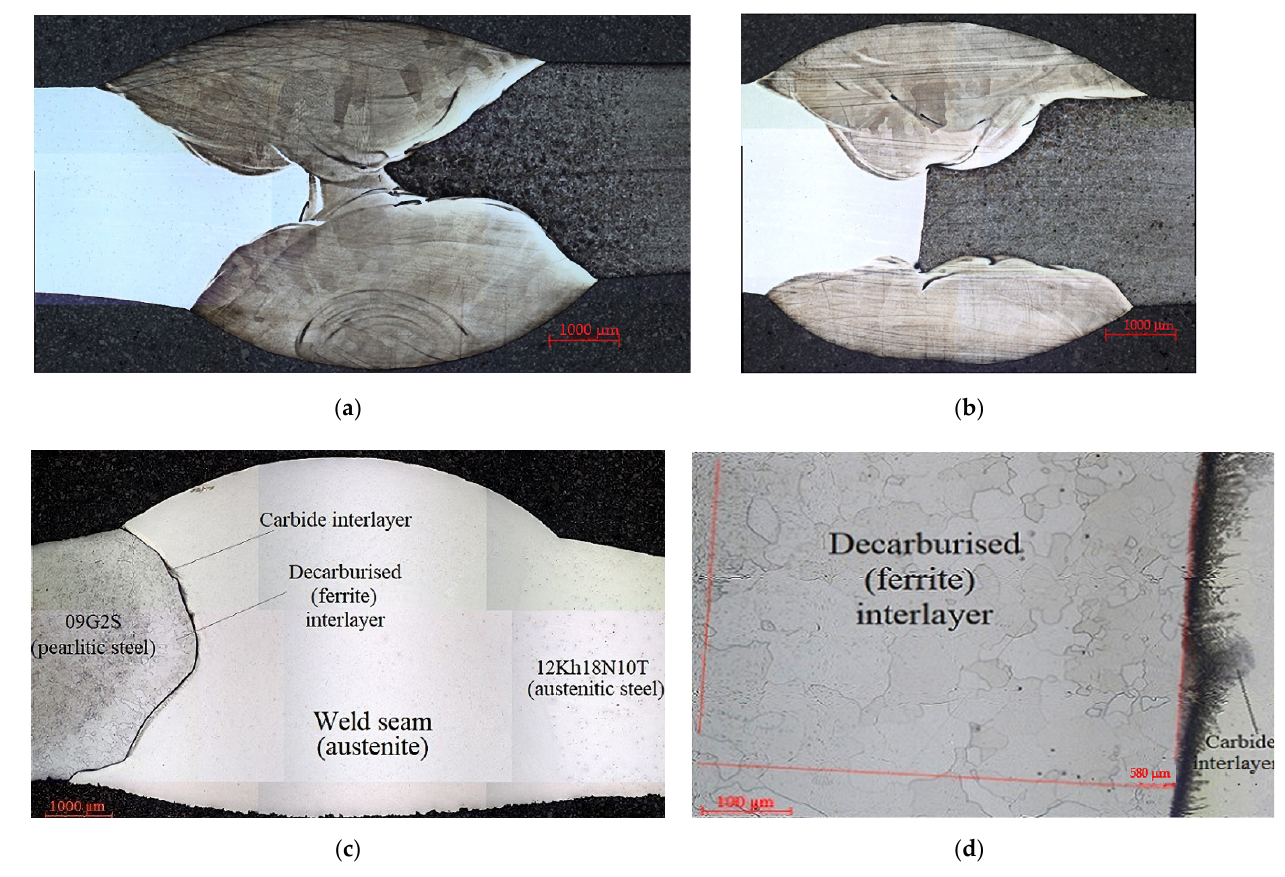
Figure 2. Transverse metallographic sections of dissimilar welded joints of steel 09G2S and 12Kh18N10T: plates pair No.1, without defects ( a ); plates pair No.2, with lack of penetration ( b ); plates pair No.3, after heat treatment, with diffusion interlayers ( c , d ).